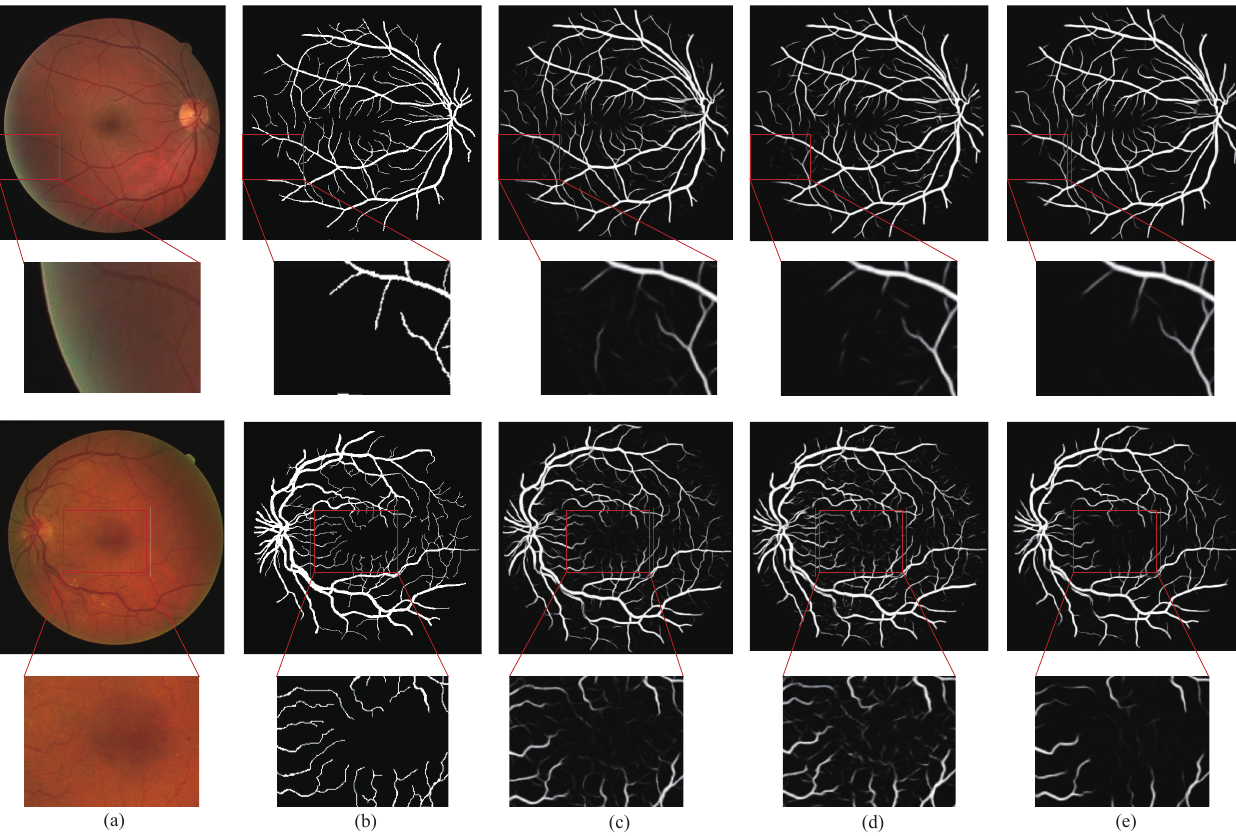
Figure 5. Comparison of the attention module visualization results on the DRIVE dataset. ( a ) Image; ( b ) ground truth; ( c ) ECA-Net [26]; ( d ) CE-Net [28]; ( e ) our